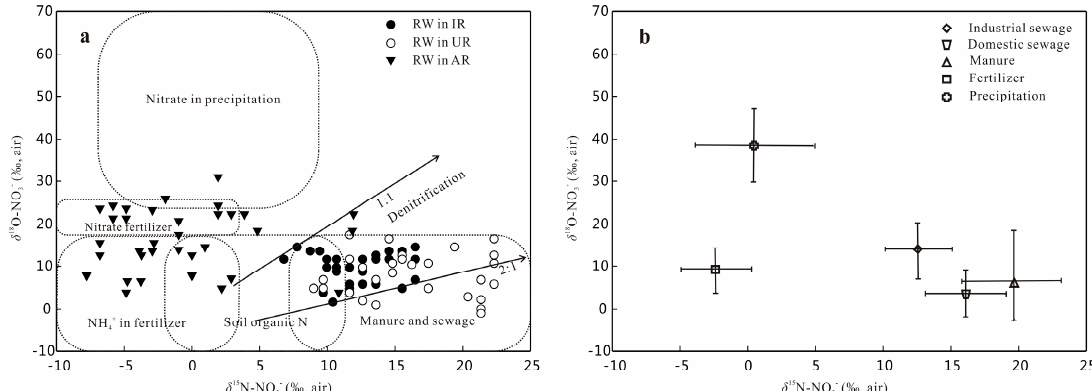
Figure 6. Relationship between δ 15 N–NO 3 − and δ 18 O–NO 3 − ( a ), and the end members of atmospheric N, chemical fertilizer, and sewage and manure in the lower reach of Fenhe River ( b ). The dotted contoured fields are based on those by Kendall [51,52]. RW in IR: river water in industrial region; RW in UR: river water in urban region; RW in AR: river water in agricultural region.